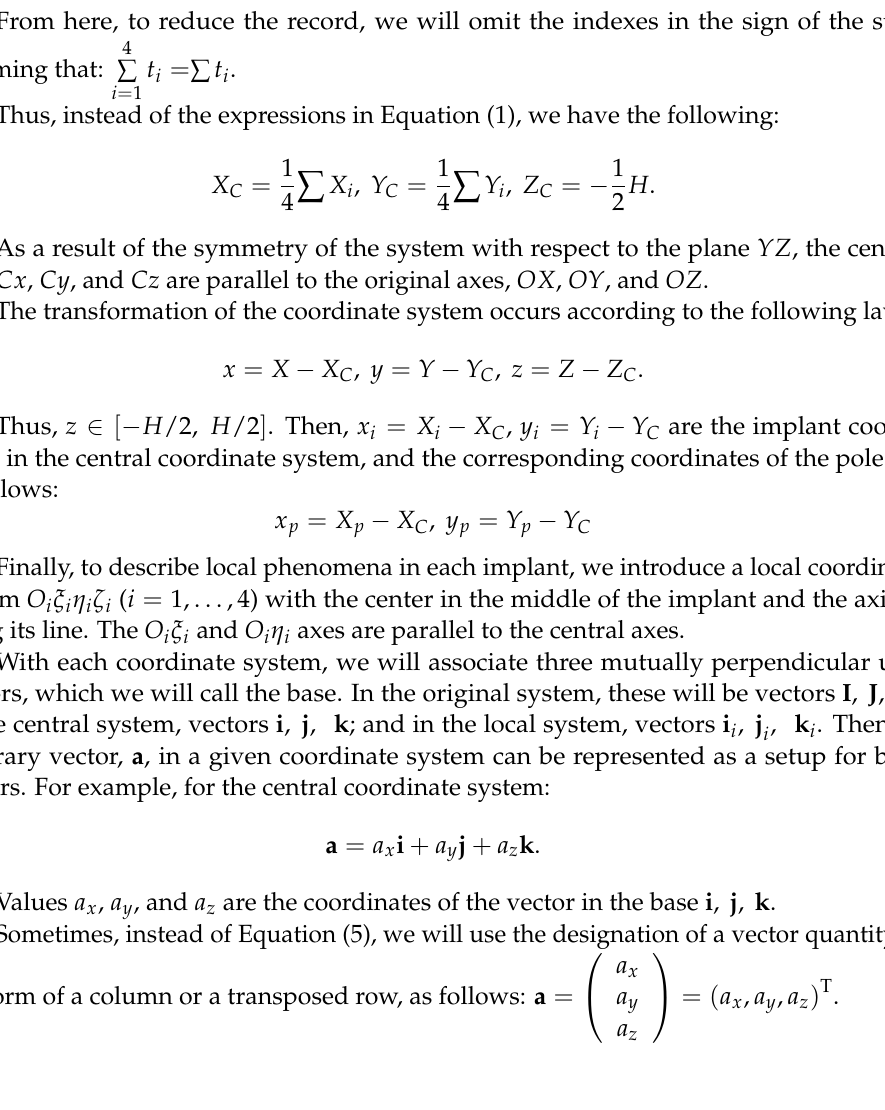
Figure 5. Central coordinate system (the Cz axis is directed at the reader): red—implants, blue—pole.